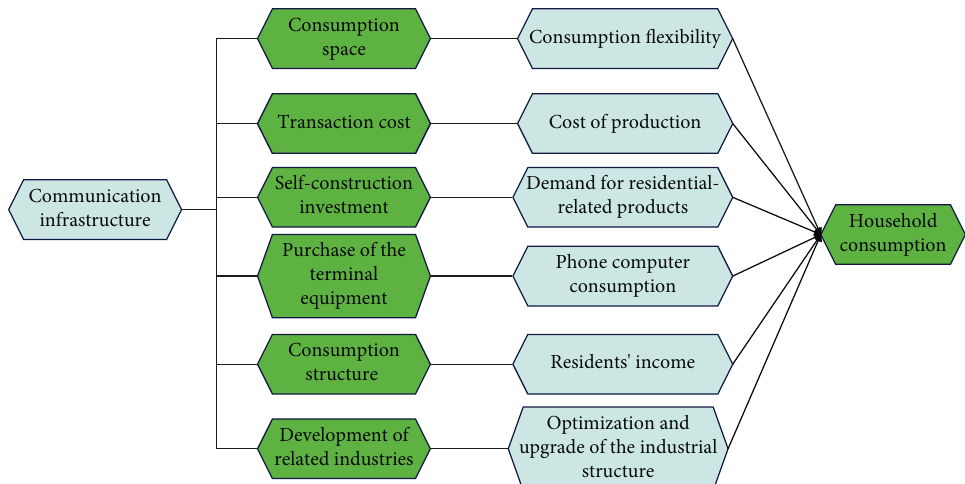
Figure 4: The mechanism of communication infrastructure on residents’ consumption.